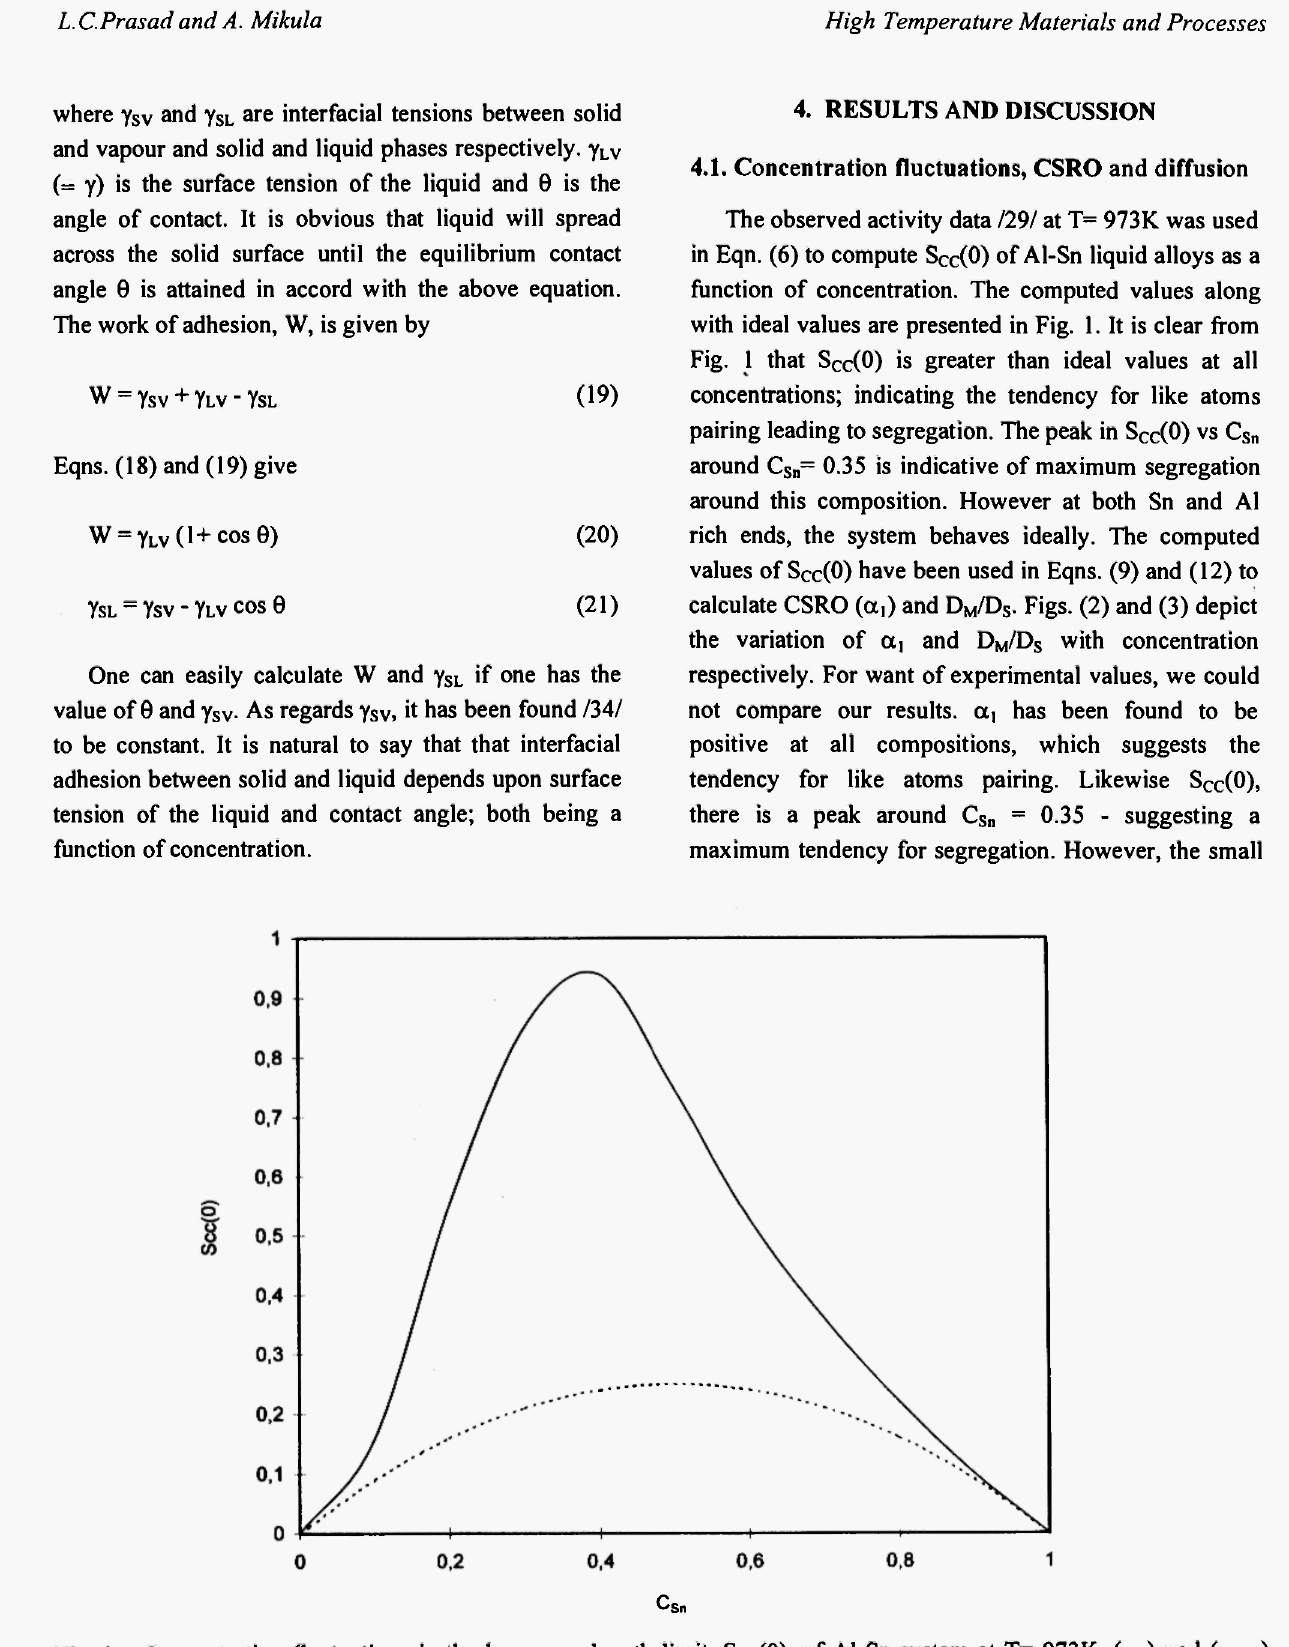
Fig. I: Concentration fluctuations in the long wavelength limit, S cc (0), of Al-Sn system at T= 973K. (—) and ( refer to computed and ideal values